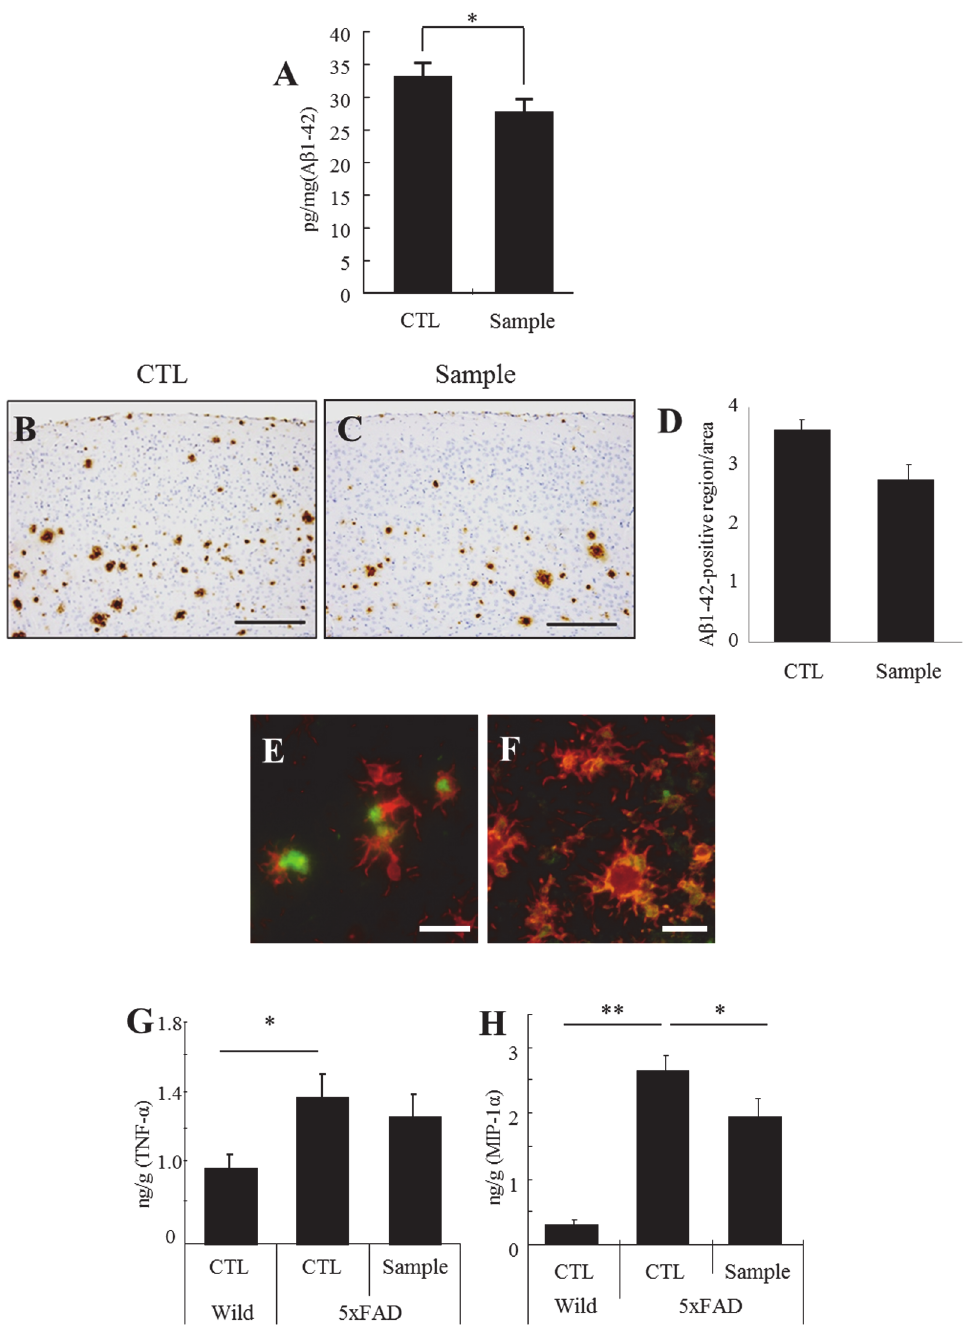
Fig 1. A β deposition and inflammation in the brain of mice fed diets with or without dairy product fermented with P . candidum . Three-month-old 5xFAD transgenic mice were fed a control diet (CTL) or a diet containing 2% (w/v) extract (sample) for 3 months. A , Quantification of soluble A β 1 – 42 in the brain by ELISA. B and C , Immunohistochemical detection of A β 1 – 42 distribution in the cerebral cortex. D , Immunohistochemical analysis of A β 1 – 42 distribution in the cerebral cortex. E and F , Immunofluorescent detection of Iba-1-positive microglia (red), and either A β 1 – 42 or MIP-1 α (green), respectively. G and H , Quantification of cytokines (TNF- α ) and chemokine (MIP-1 α ) in the hippocampus by ELISA. Error bars represent the means ± SEM of 11 mice per group. ** p < 0.01 and * p < 0.05. Scale bars represent 200 μ m (B and C) and 20 μ m (E and F)